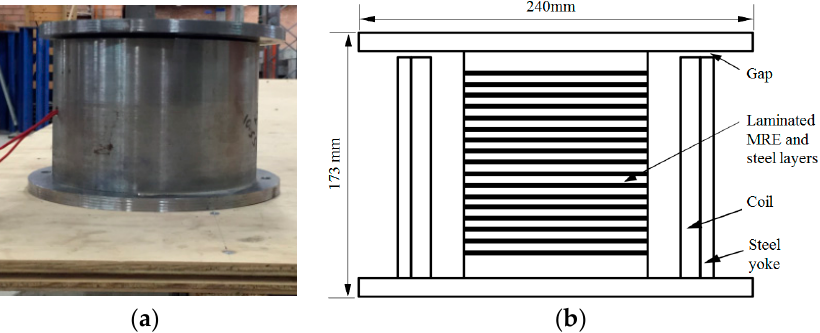
Figure 10. Design of the prototype MRE isolator. ( a ) Photo of the device; ( b ) Cross-section of the device.